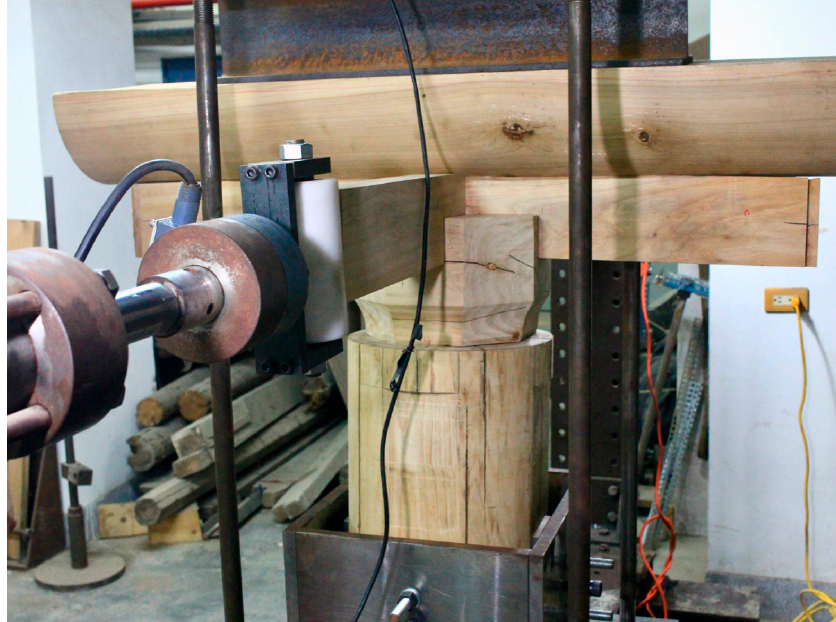
Figure 11. Testing rig and specimen of shear